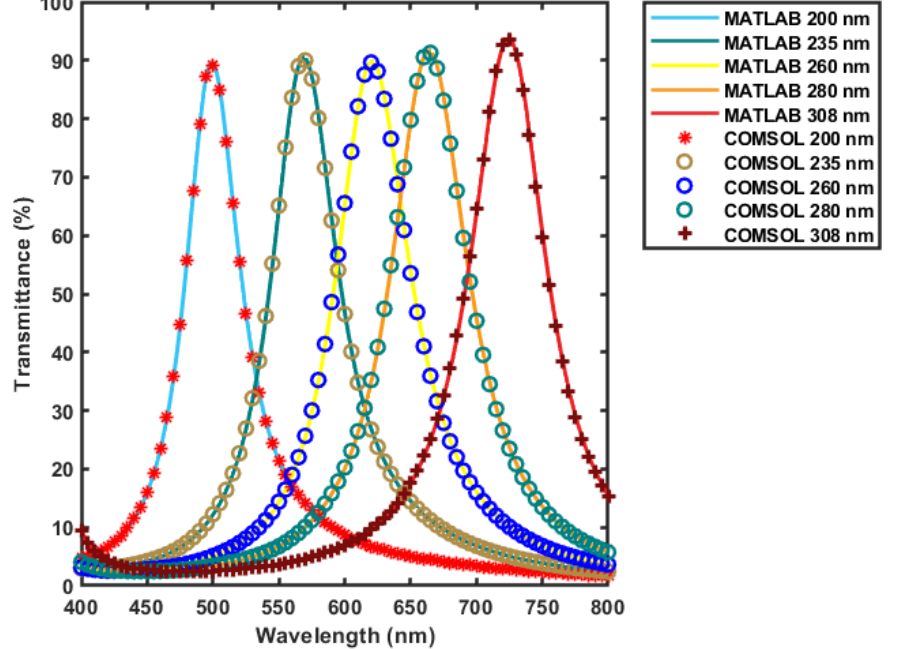
Figure 6. Comparing the transmission spectra of the filter optimized for maximum transmission at different gap values obtained from COMSOL and MATLAB.